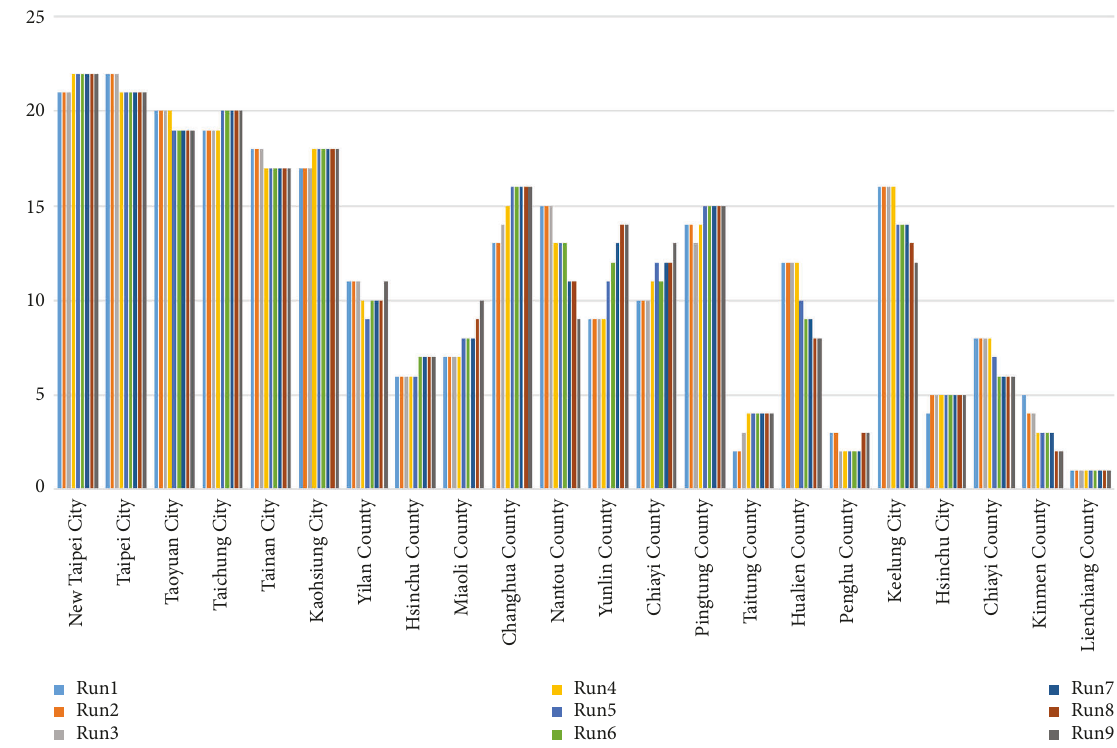
Figure 8: Sensitivity analysis: other crimes ( C